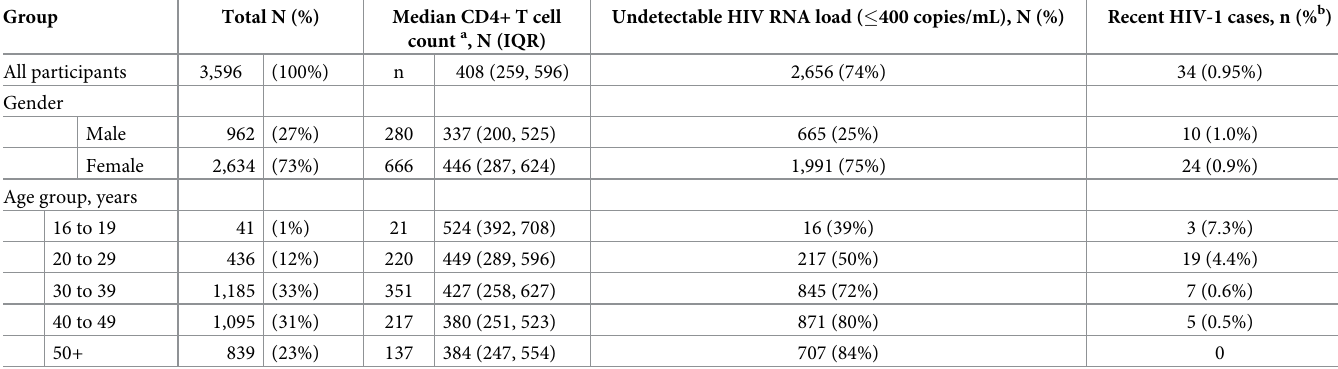
Table 1. Summary of baseline characteristics of HIV-infected participants enrolled in BCPP in 30 Botswana